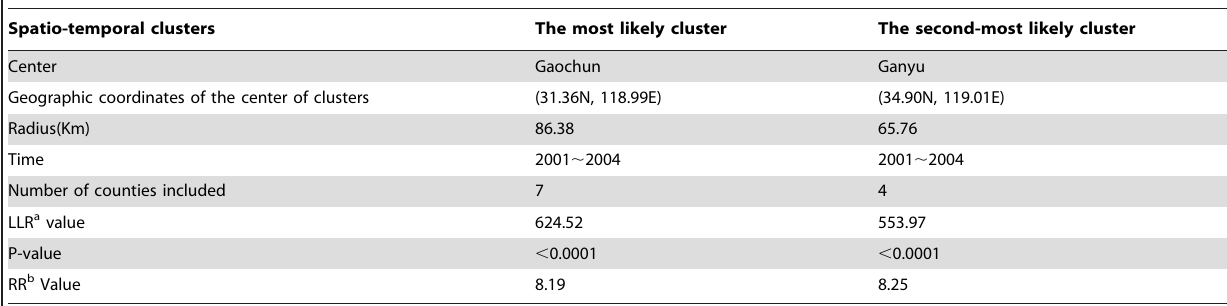
Table 2. Spatio-temporal clustering on HFRS in Jiangsu from 2001 to 2011.